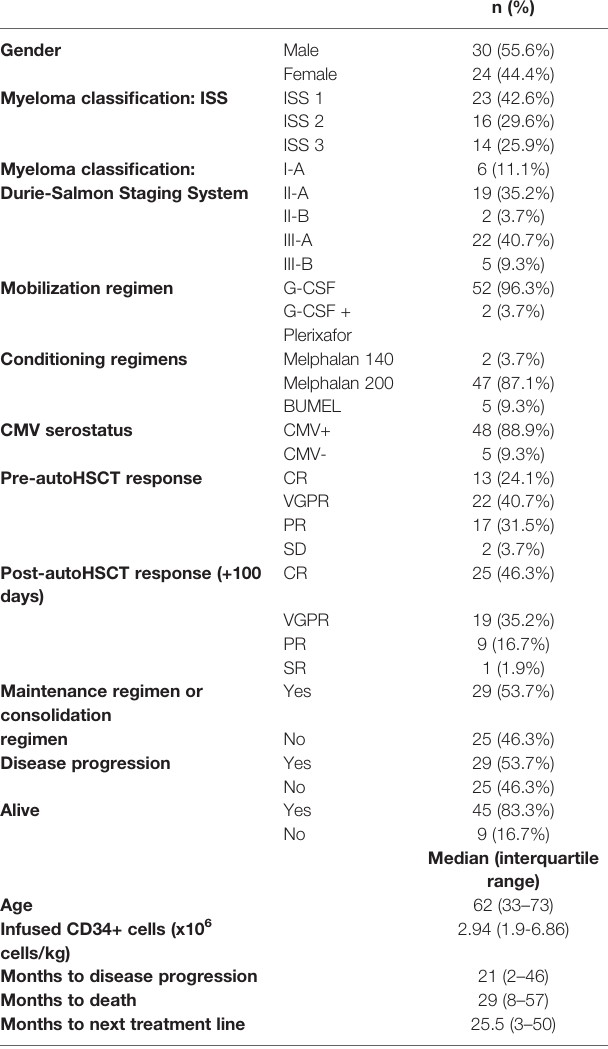
TABLE 1 | Patients´